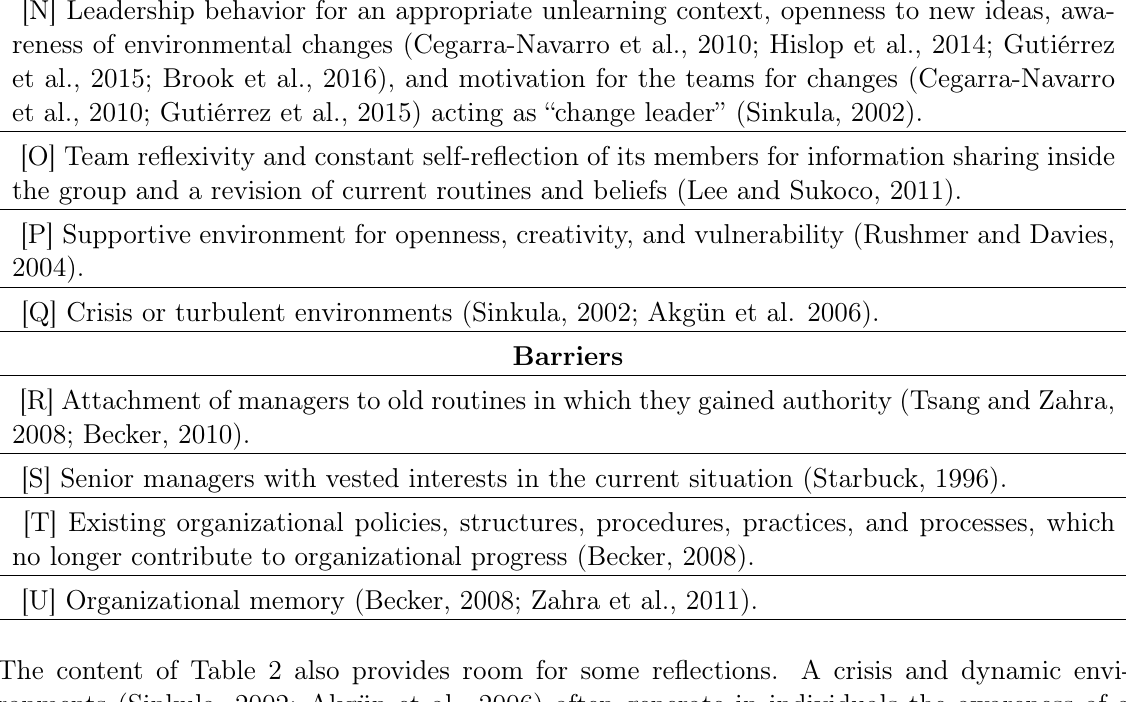
Table 2 . External Factors for Individual Unlearning